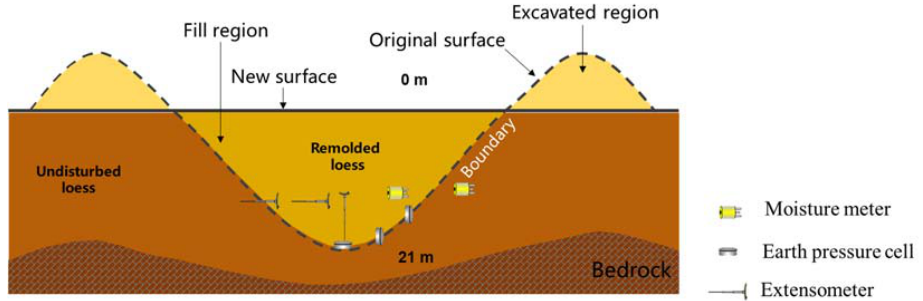
Figure 5. Schematic diagram of buried equipment layout.